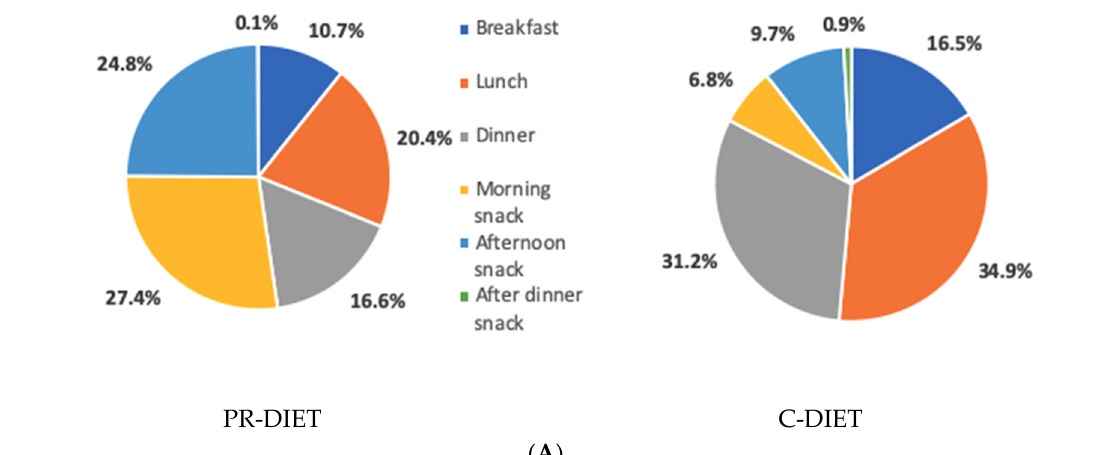
All data are expressed as mean ± standard deviation (SD); PR, polyphenol-rich diet; C, control diet. † Comparison between PR-diet vs. C-diet in women. ¥ Comparison between PR-diet vs. C-diet in men. # Comparison between women and men in PR-diet and C-diet. § Comparison between PR-diet vs. C- diet in all subjects. Comparisons have been performed using the Wilcoxon–Mann–Whitney test.